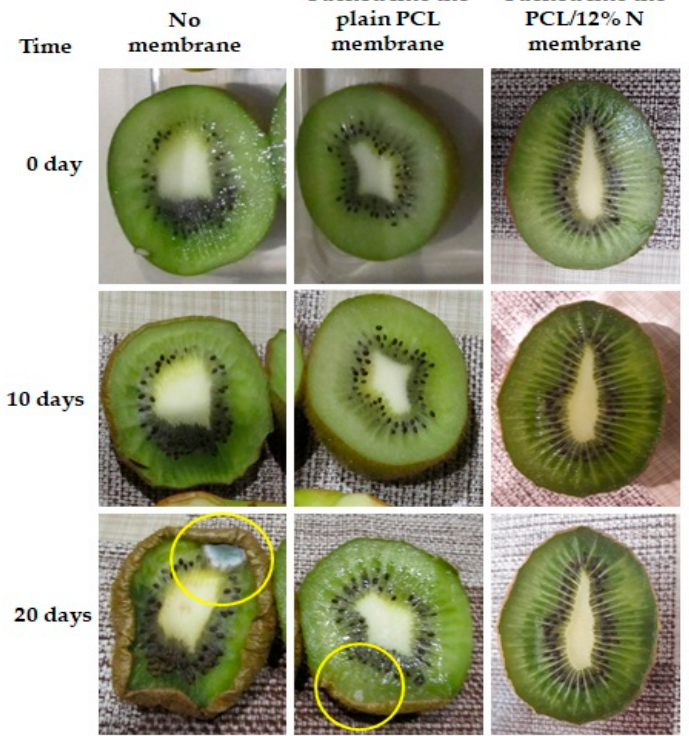
Figure 9. Observational experiments over time with kiwi for suitability of fibers-based food packaging. The yellow circle highlights the rot.